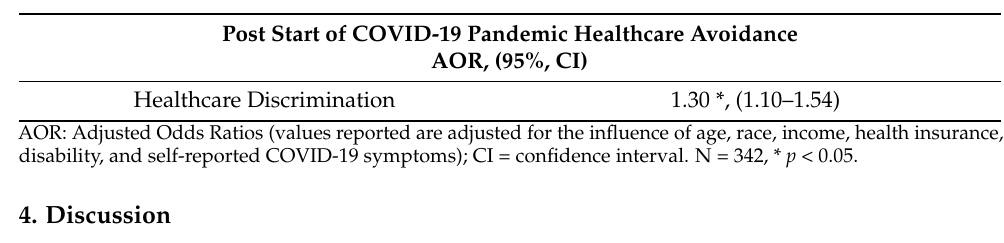
Table 3. Logistic Regression Analysis: Childhood exposure to healthcare discrimination and health- care avoidance during the early months of the COVID-19